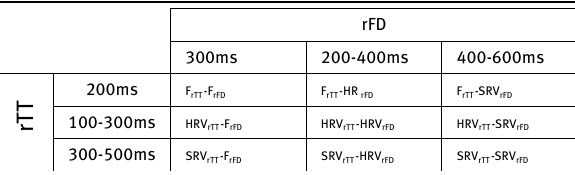
Table 1: Summary of the experimental conditions for rTT (Robot Tra- jectory Time) and rFD (Robot Fixation Duration).